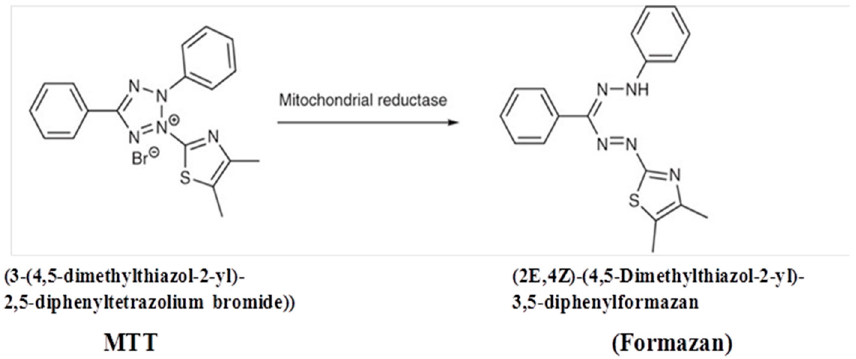
Figure 7. Conversion of MTT dye to Formazan.